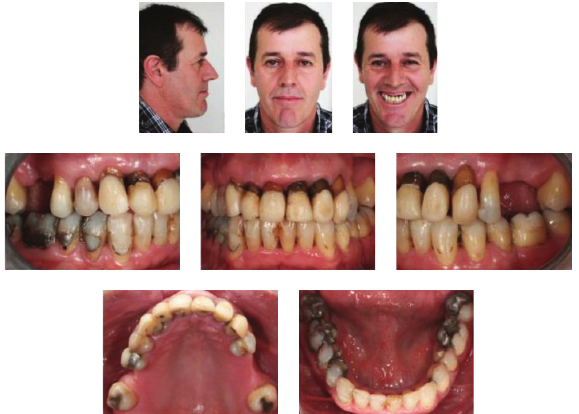
Figure 5: Posttreatment facial photographs and intraoral pho-